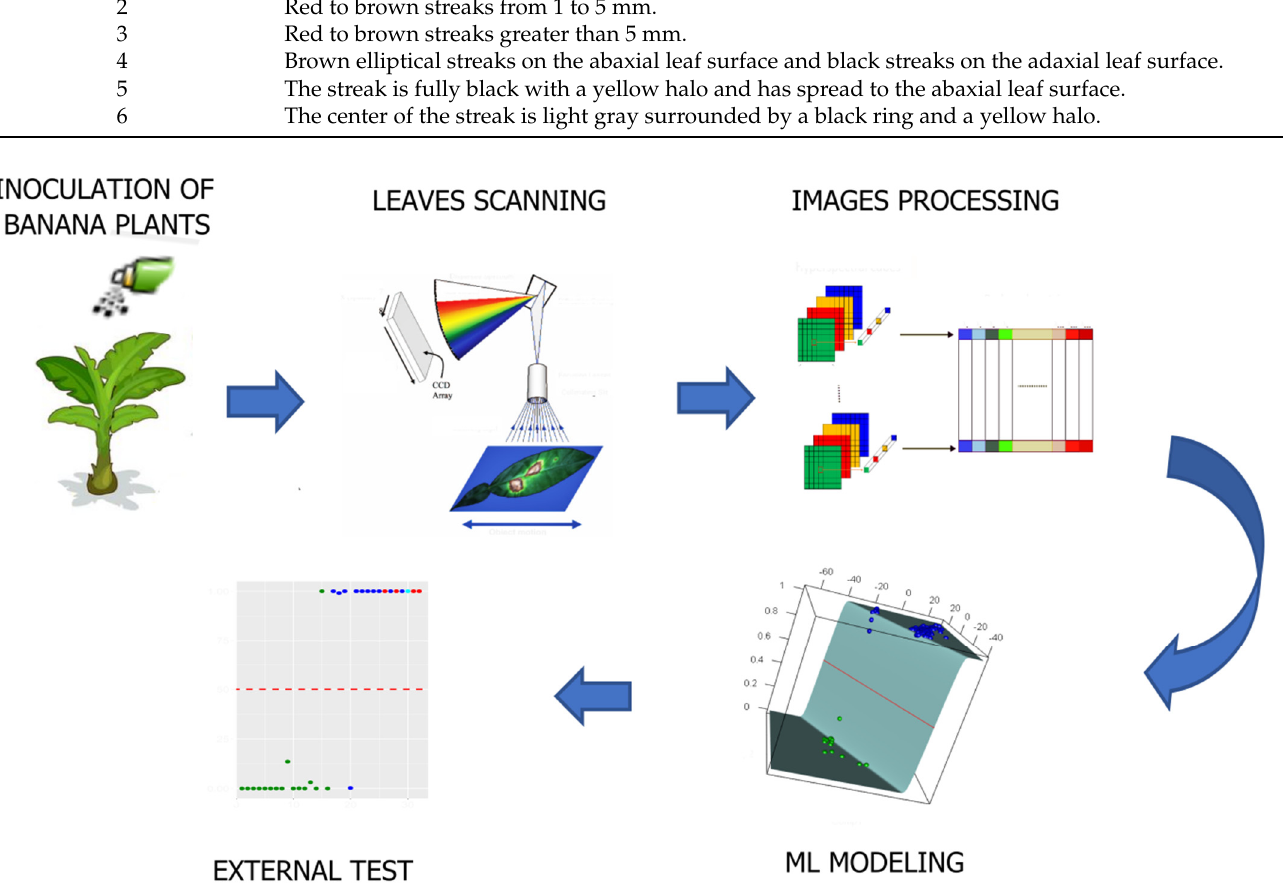
Figure 2. Schematic diagram of the research process to detect black sigatoka disease using hyper- spectral